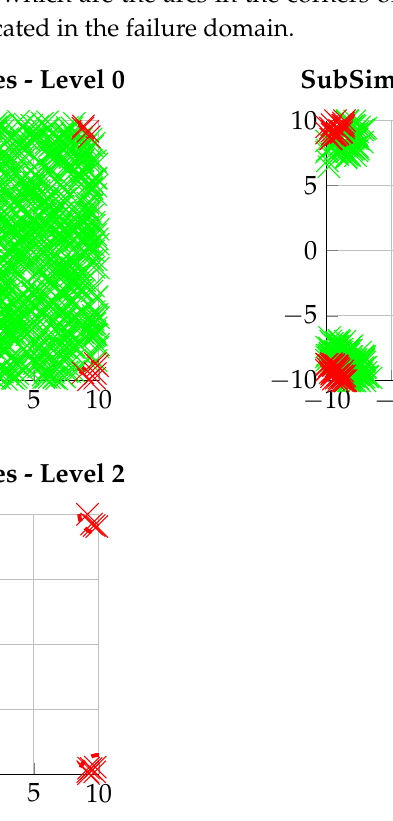
Figure 2. General behavior of subset simulation with modified Metropolis–Hastings algorithm and p 0 = 0.1 showing movement of the samples (red: in failure domain, green: not in failure domain) over the different subset levels with arc failure domains at